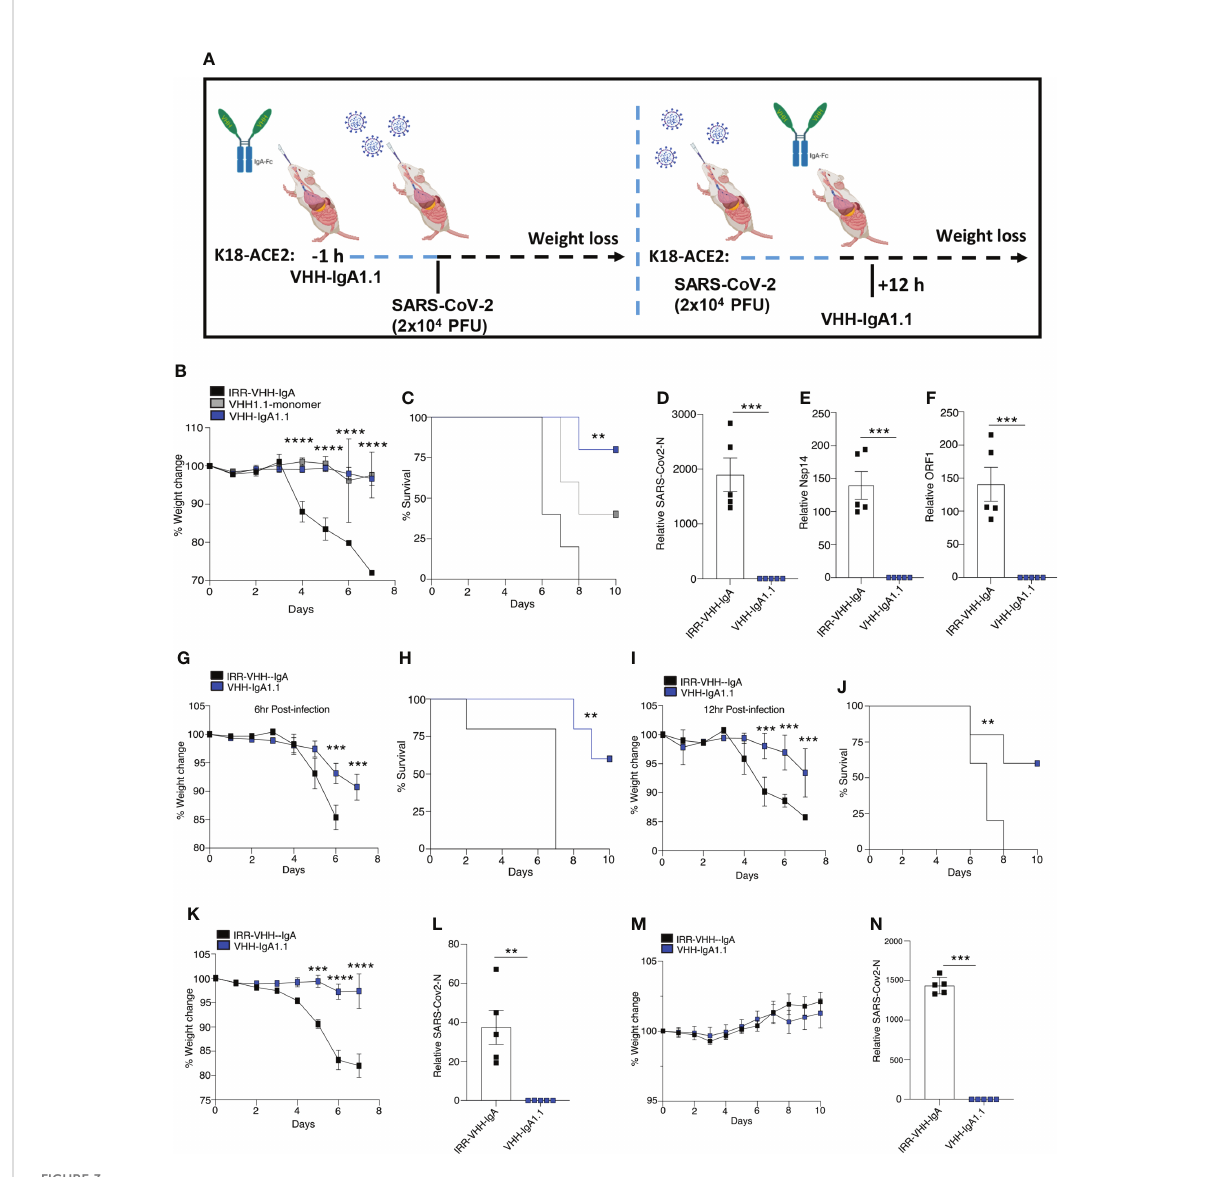
FIGURE 3 Single-dose intranasal VHH-IgA1.1 protects K18-ACE2 transgenic mice from SARS-CoV-2 infection. (A) Schematic of VHH-IgA1.1 intranasal delivery and SARS-CoV-2 infection. ( B, C) Weight loss (B) and survival (C) of K18-ACE2 transgenic mice infected intranasally with SARS-CoV-2 (2.5x10 4 PFU/mouse) with a 1 h intranasal pre-treatment of 10mg/kg IRR-IgA isotype control ( n=5 ), VHH-monomer ( n=5 ) or VHH-IgA1.1 (D-F) QPCR analysis of SARS-CoV-2-N (D) , Nsp14 (E) ORF1 (F) in lung tissue of K18-ACE2 transgenic mice infected with SARS-CoV-2 for 48 h with a 1 h intranasal pre-treatment of 10mg/kg IRR-IgA1 isotype control ( n=5 ) or VHH-IgA1.1 ( n=5 ). (G – J) Weight loss and survival of K18-ACE2 transgenic mice infected intranasally with SARS-CoV-2 (2.5x10 4 PFU/mouse) and treated with 10mg/kg IRR-IgA1 isotype control ( n=5 ) or VHH- IgA1.1 ( n=5 ) 6 h (G, H) or 12 h (I, J) after infection. ( K, M ) Weight loss of K18-ACE2 transgenic mice infected intranasally with Alpha (K) and Omicron (N) (1x10 5 PFU/mouse) variant of SARS-CoV-2 followed by pre-treatment of 10mg/kg IRR-IgA1 isotype control ( n=5 ) or VHH-IgA1.1 ( n=5 ). (L , N) QPCR analysis of SARS-CoV-2-N in lung tissue of K18-ACE2 transgenic mice infected with SARS-CoV-2 Alpha (L) and Omicron (N) for 48 h with a 1 h intranasal pre-treatment of 10mg/kg IRR-IgA1 isotype control ( n=5 ) or VHH-IgA1.1 ( n=5 ). ** p <0.001 *** p <0.0001, **** p <0.00001. ( C , H , J Mantel – Cox survival analysis). Error bars show means ±